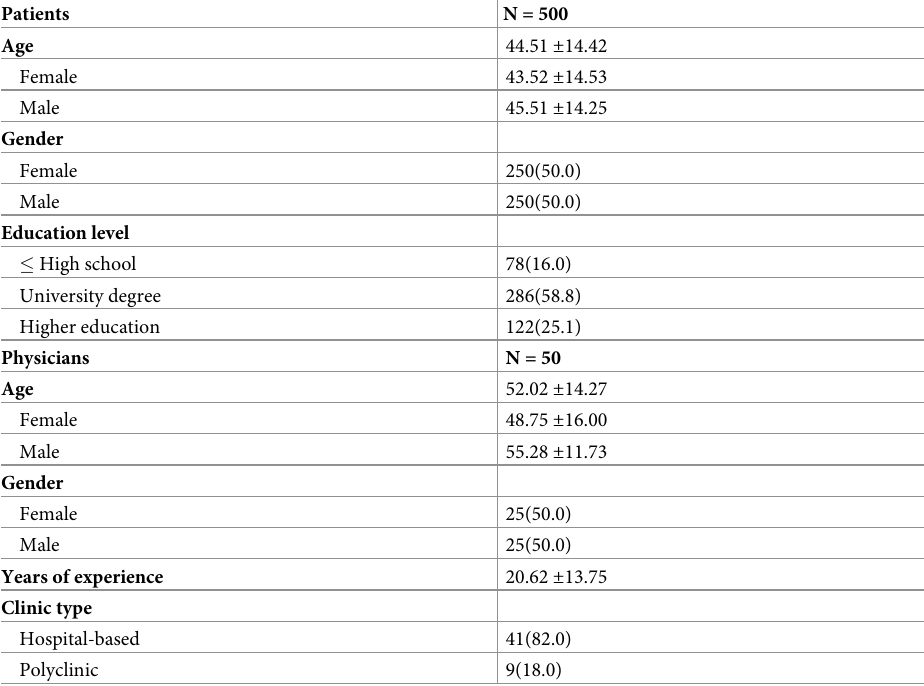
Table 1. Demographic characteristics of study